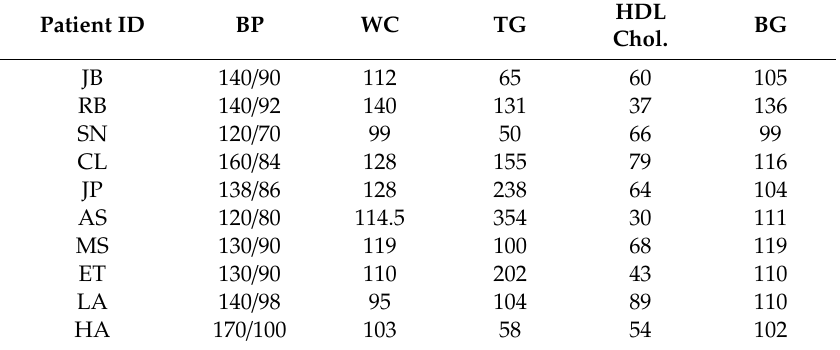
Table 5. Baseline data from 10 MetS patients with 5 / 5 CVD risk factors. All of them were receiving treatment for their baseline